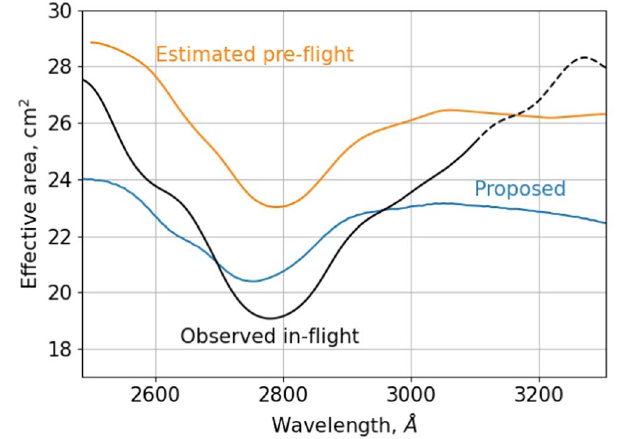
Figure 6. Effective area of the CUTE instrument as proposed ( blue ) , estimated with laboratory measurements ( orange ) , and calculated in- fl ight and smoothed ( black ) . The in- fl ight effective area beyond λ ≈ 3100 Å is estimated based on a model fi t to the IUE ζ Puppis one-dimensional